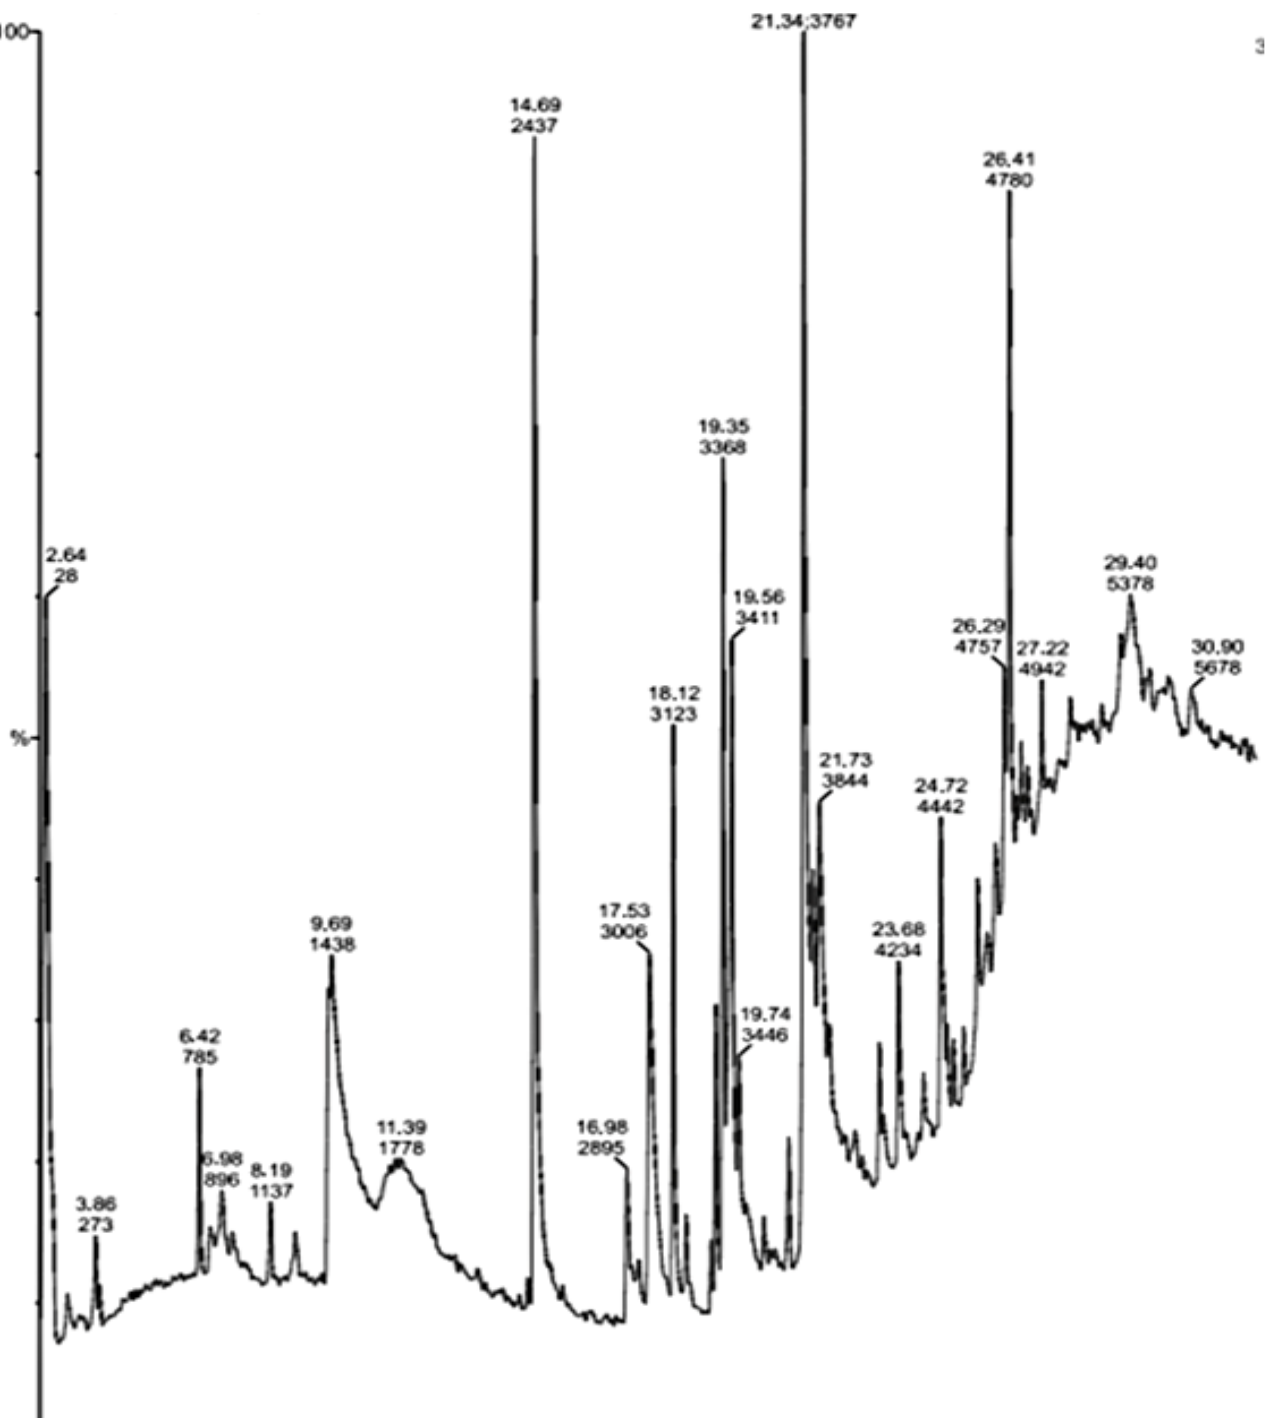
Figure 4. GC ‐ MS chromatogram of ethyl acetate extract of Beijerinickia fluminensis. Figure 4. GC-MS chromatogram of ethyl acetate extract of Beijerinickia fluminensis